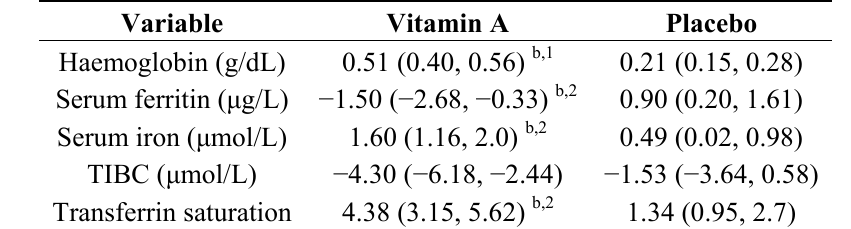
Table 3. Mean changes in Hb and iron status indices from baseline 3 months after intervention in the vitamin A and placebo groups a